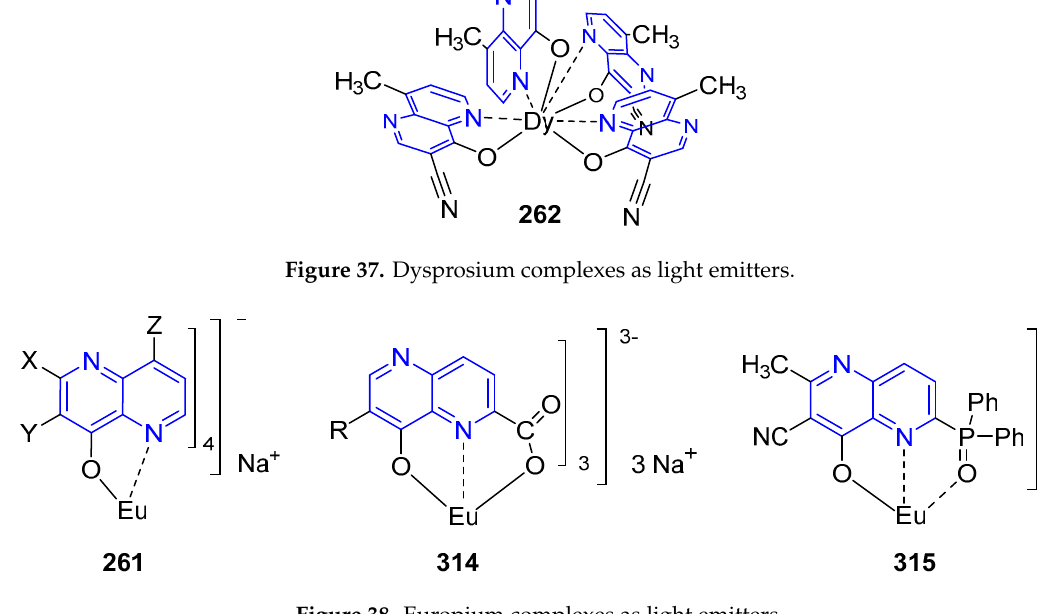
Figure 38. Europium complexes as light emitters.